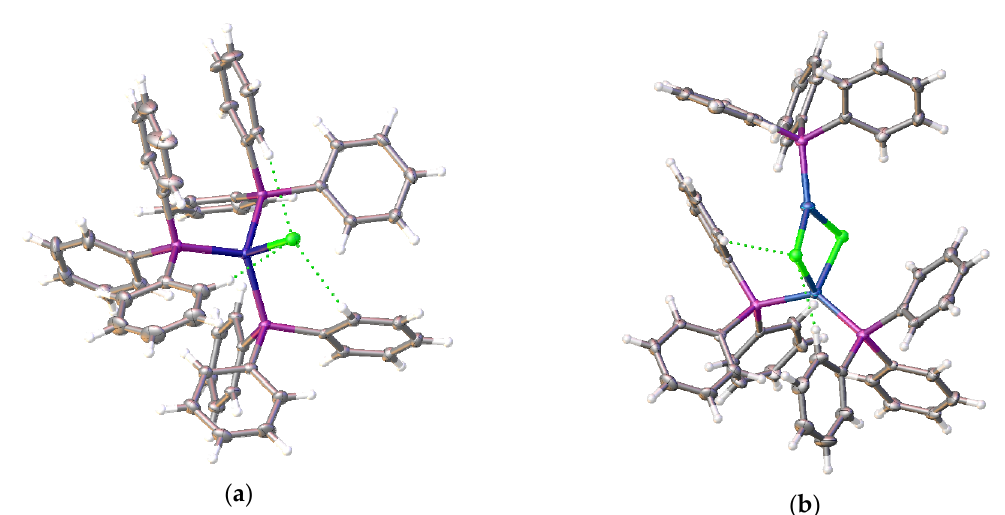
Figure 2. Molecular view of ( a ) 3 and ( b ) 4 in representation of atoms with thermal ellipsoids ( p = 50%). Solvent molecules are